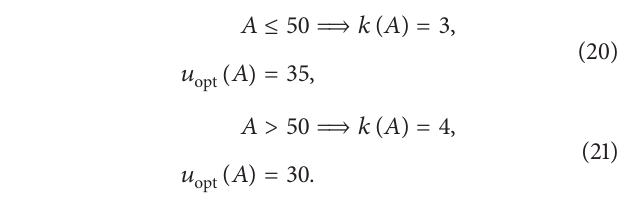
deviation in ocular media increases with age (Figure 3, left), and the order of magnitude is consistent with Bennett et